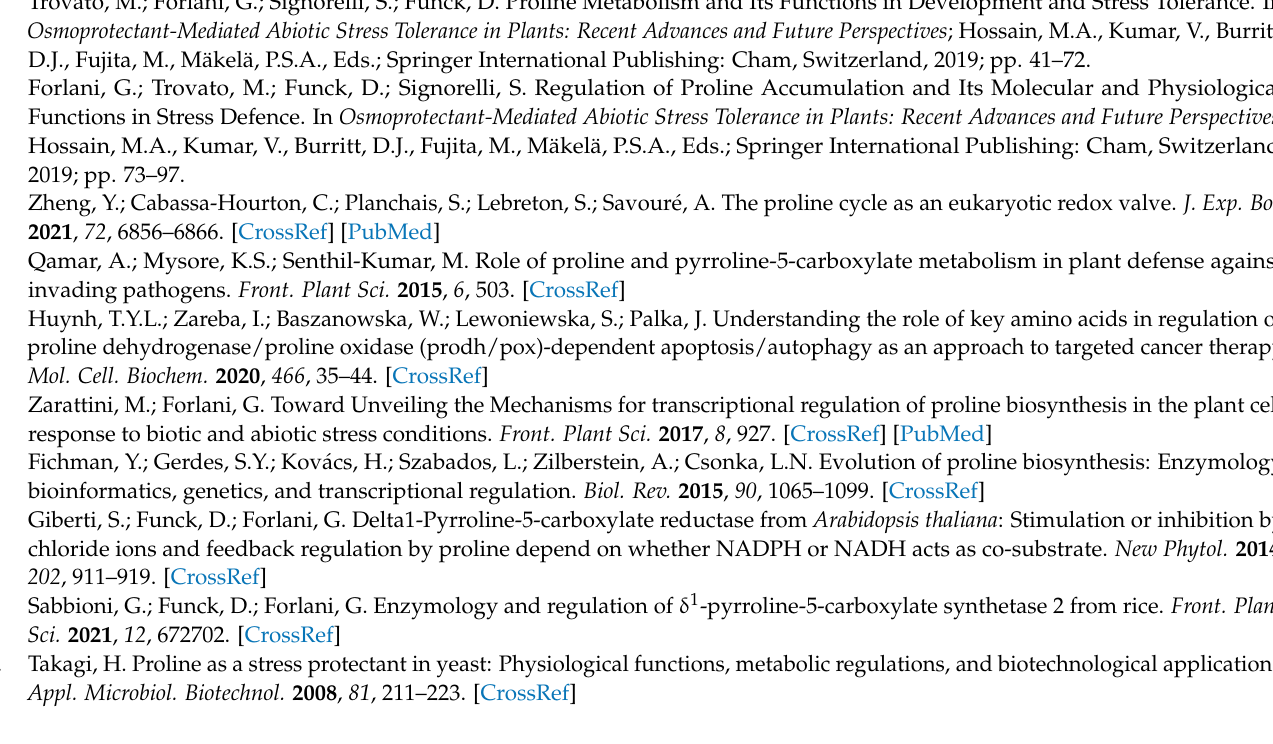
P5C reductase; Figure S2: Substrate affinity of yeast P5C reductase; Figure S3: Phylogenetic tree depicting the position of the yeast enzyme among the predicted members of the P5C reductase family; Figure S4: Multiple sequence alignment of Saccharomyces cerevisiae P5C reductase and selected representatives of the P5C reductase family; Figure S5: Distribution of electrostatic potential on the Sc P5CR